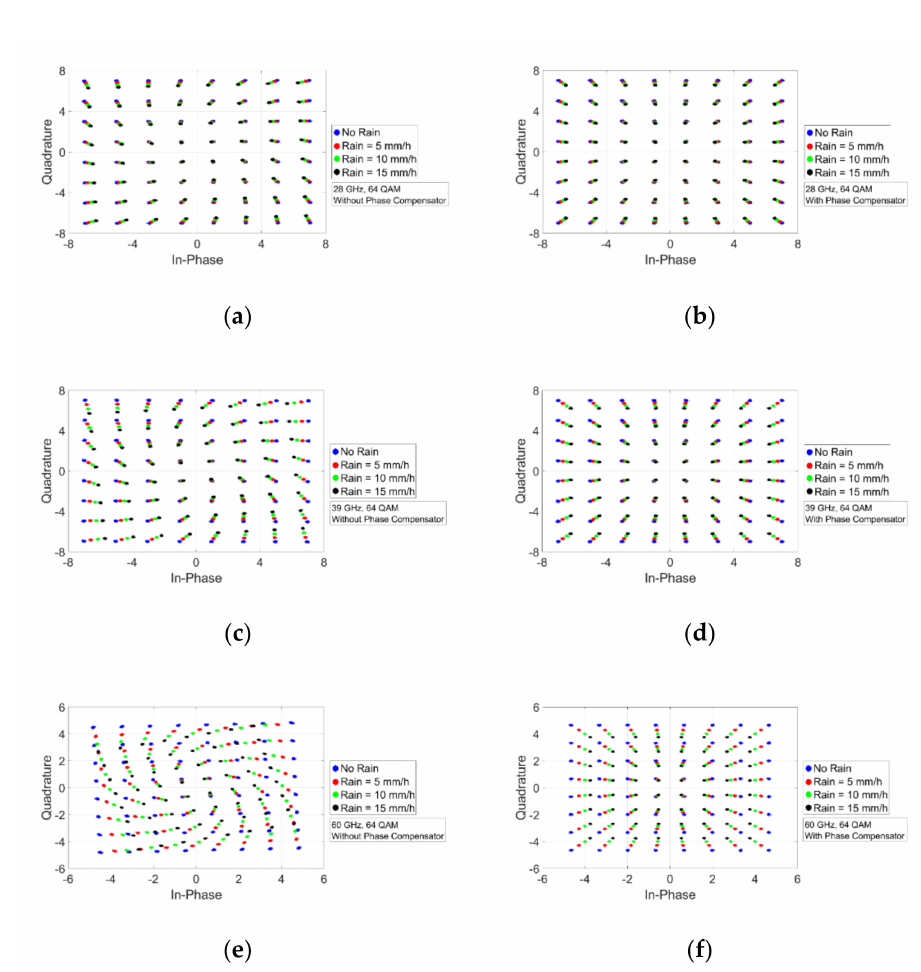
Figure 4. Simulation results of 64 QAM constellation diagram and e ff ect of Phase Compensator on it at carrier frequencies: ( a , b ) 28, ( c , d ) 39, ( e , f ) 60 GHz for 200 m wireless link in di ff erent rainfall